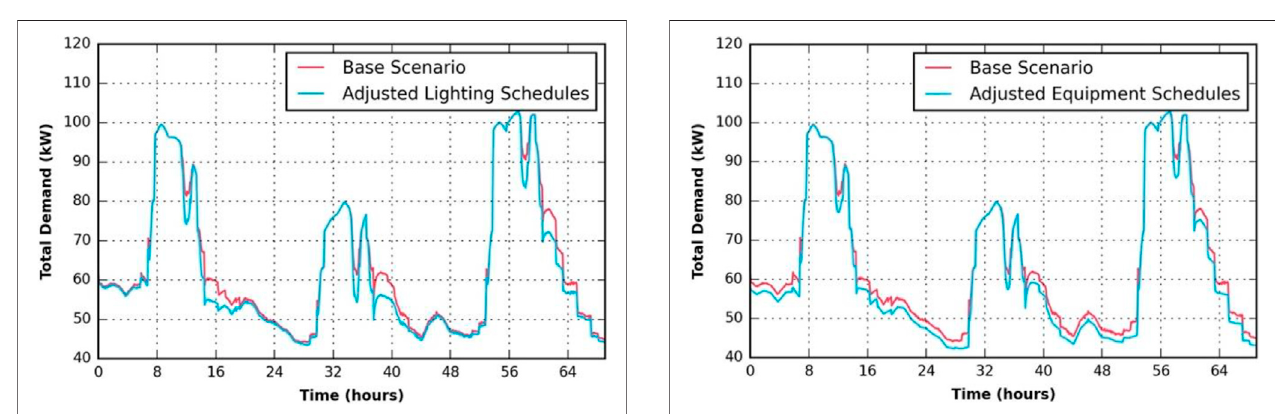
FIGURE 16 | Improving building electricity consumption by controllable of fi ce equipment following occupancy patterns.